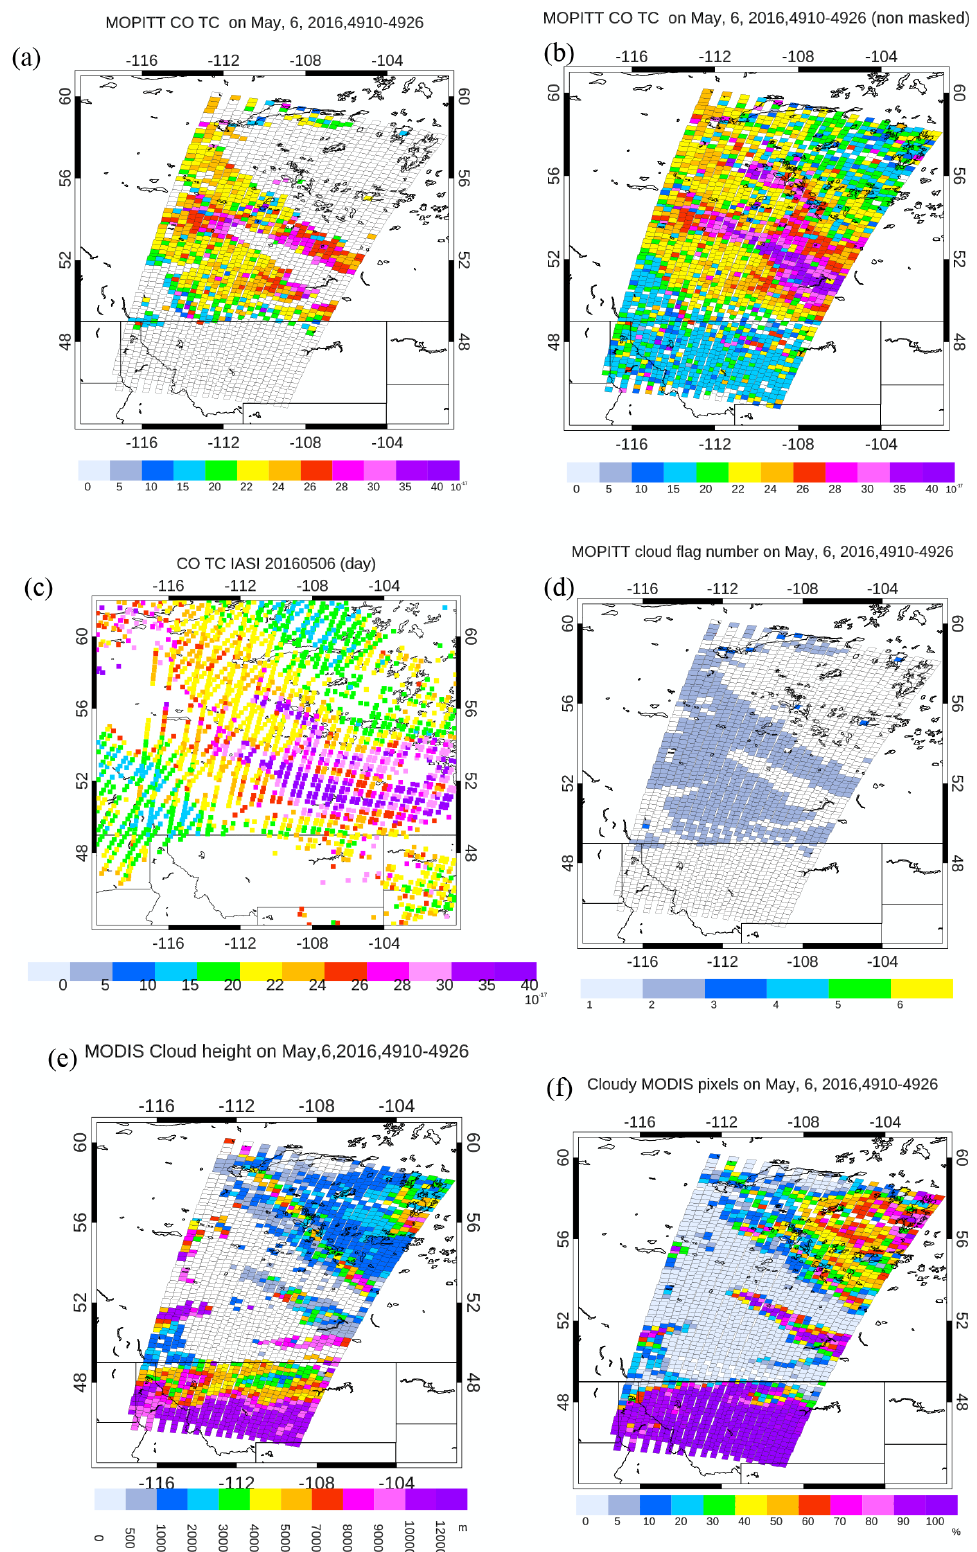
Figure 8. The same as Fig. 3 but for 6 May